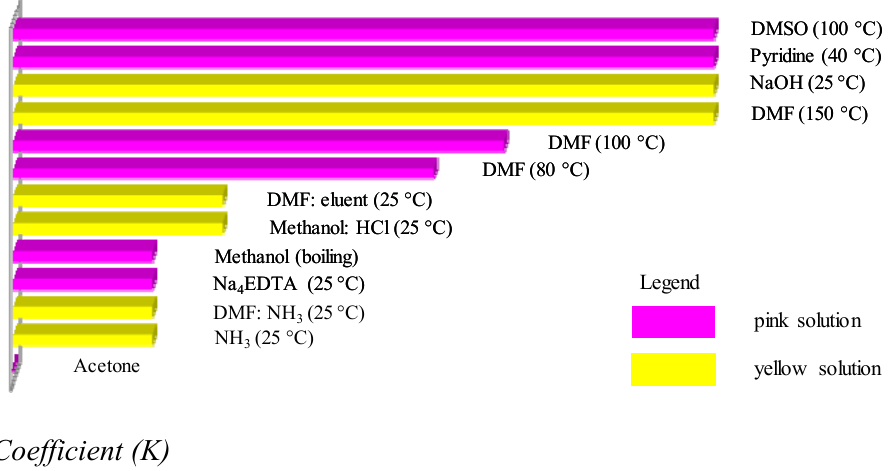
Figure 2. Comparison of the carthamin-extraction abilities of various solvents.